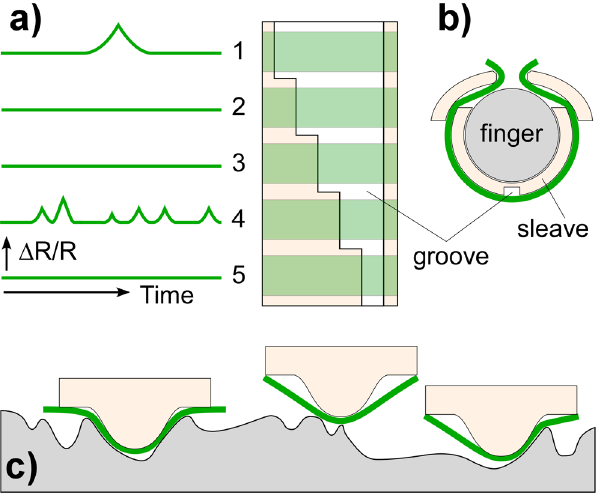
Figure 8. Alternative embodiments. ( a ) Multiple strips over a variable-width groove would provide information concerning surface texture of different sizes. ( b ) The sensor concept in the form of a retrofitable sleeve. ( c ) As a variant configuration, a membrane stretched over a protrusion could also be used to probe surface